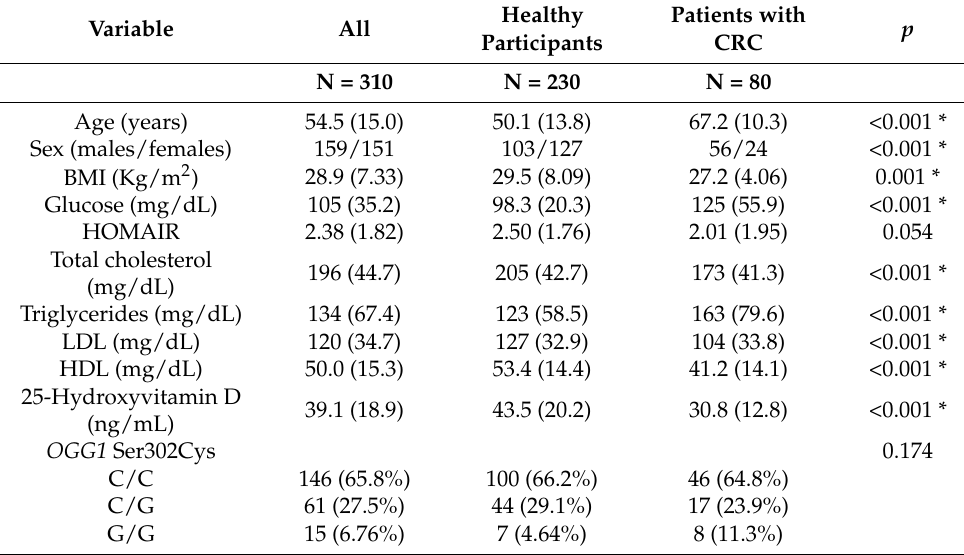
Table 1. The baseline characteristics of the participants included in the study. Variable All